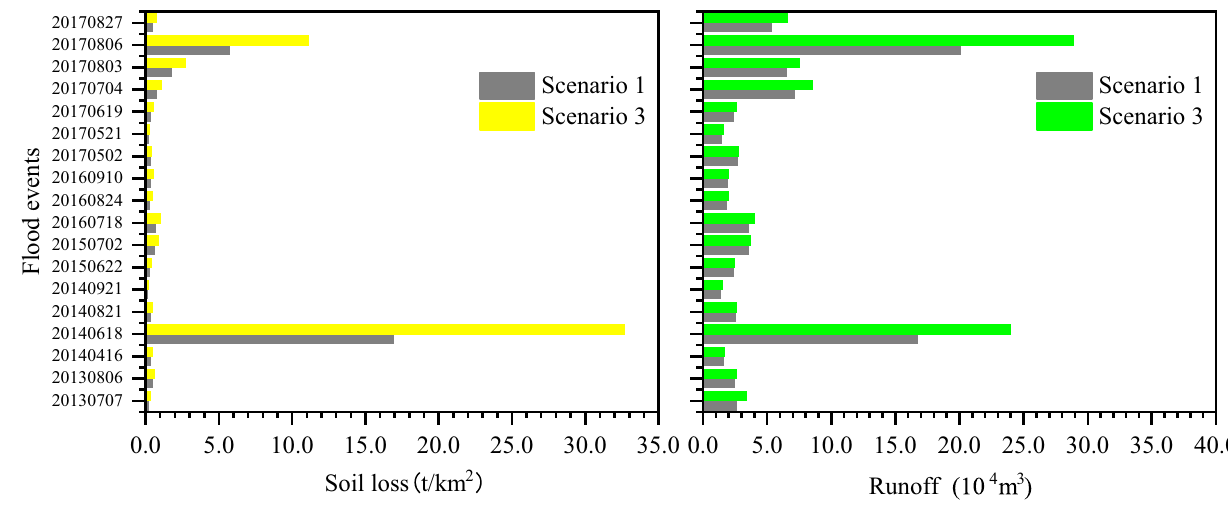
Fig. 13 Effect of terrace on reducing runoff and